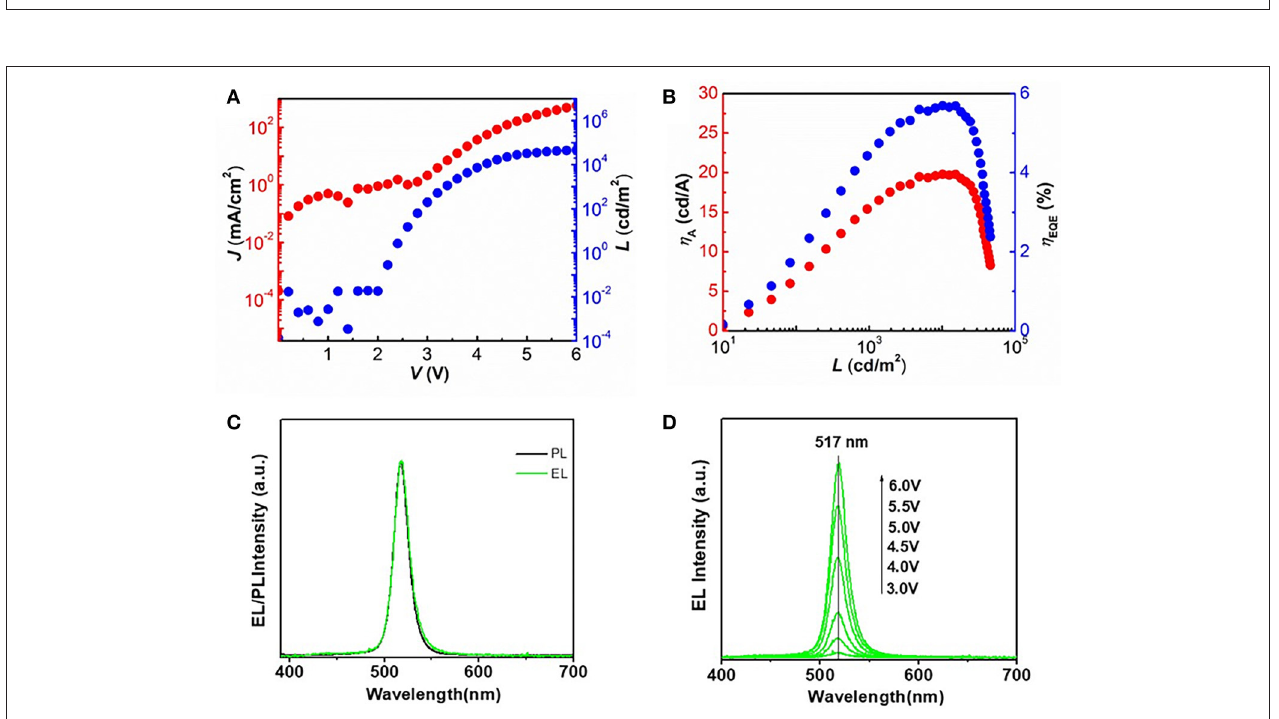
FIGURE 5 | (A) Current density (J) and luminance (L) vs. driving voltage characteristics for the optimized QLEDs. (B) Current efficiency ( η A ) and EQE as a function of luminance for the optimized QLEDs. (C) Normalized PL (black line) and EL spectra (green line) of the QLEDs based on perovskite CsPbBr 3 QDs. (D) Evolution of EL spectra of QLEDs with increasing bias